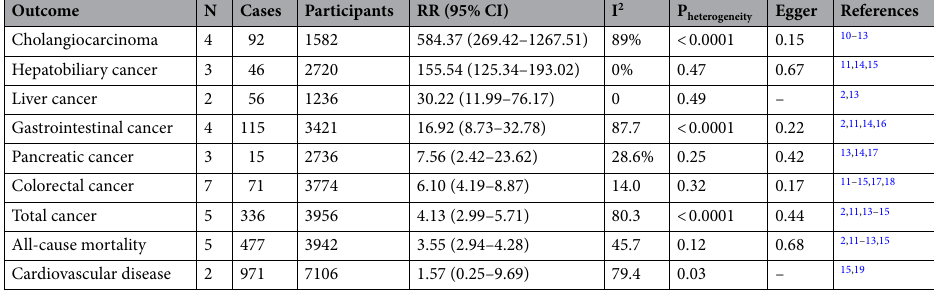
Table 1. Summary relative risks and 95% confidence intervals for the association between primary sclerosing cholangitis and cancer and all-cause